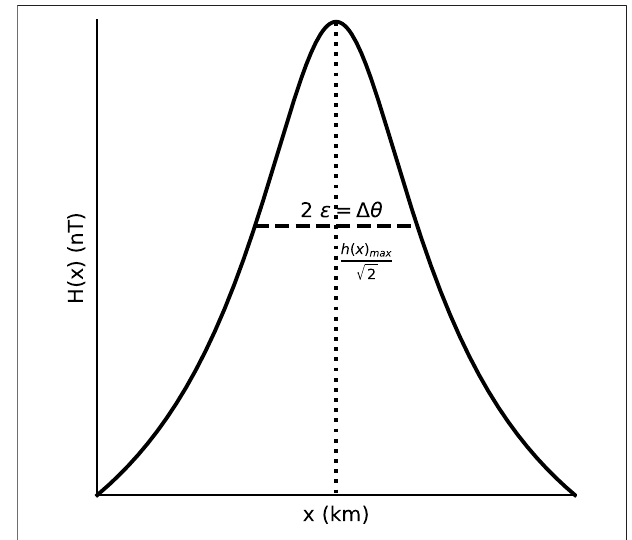
FIGURE 1 | Normalised spectral amplitude pro fi le with latitude (km) of a resonance. The characteristic latitudinal half-width, ε , occurs where H(x) is 1 (cid:8) the maximum